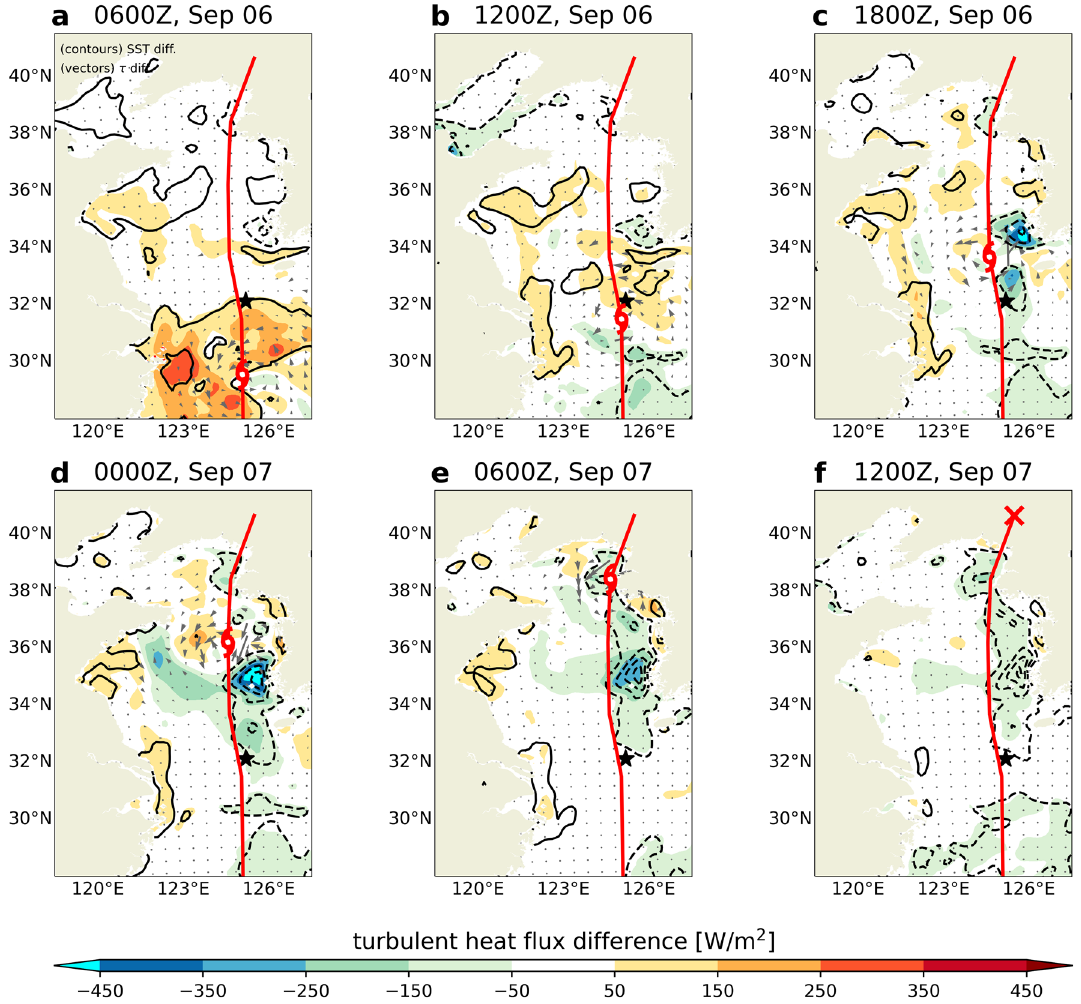
Figure 4. Horizontal distribution of surface turbulent heat flux differences (shaded) between CPL and NOCPL for the analysis domain every 6 h. The black contours denote sea surface temperature (SST) differences from − 6 to 6 by 2 °C. Grey arrows denote difference in wind stress (N/m 2 ). Red lines and typhoon symbols indicate TC tracks and TC center location for the CPL simulation, respectively. The black star indicates the location of the Ieodo